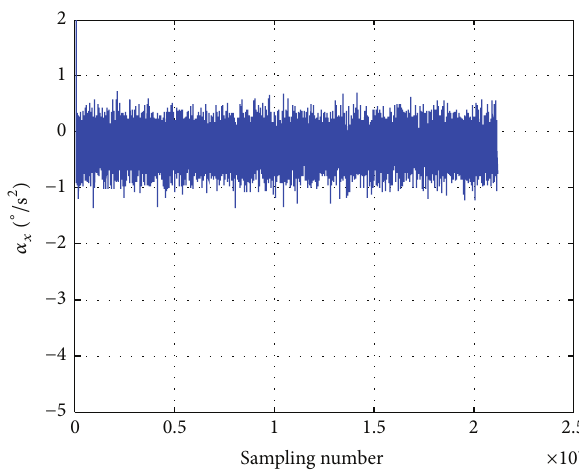
Figure 14: 𝛼 𝑥 for uncontrolled system.